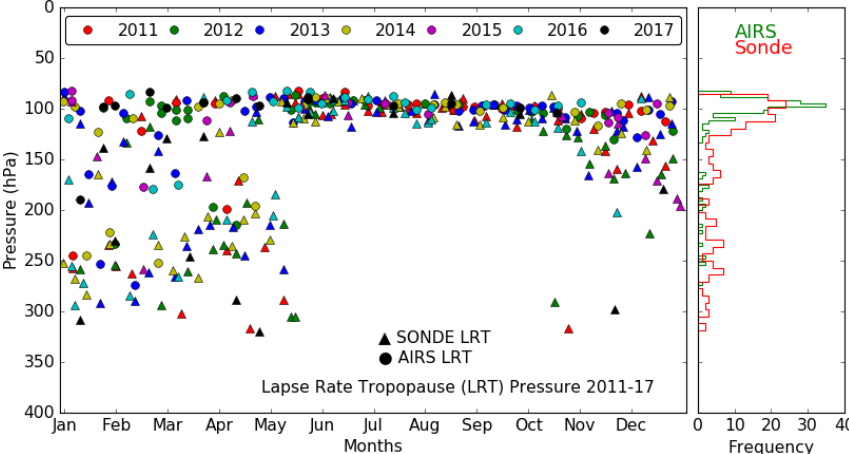
Figure 3. Lapse rate tropopause pressure monthly variation from balloon-borne and AIRS observations and respective frequency distributions during